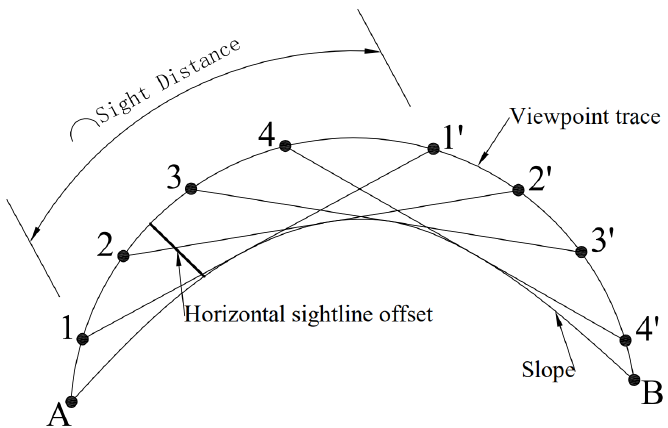
Figure 9. Horizontal sightline offset method schematic diagram.